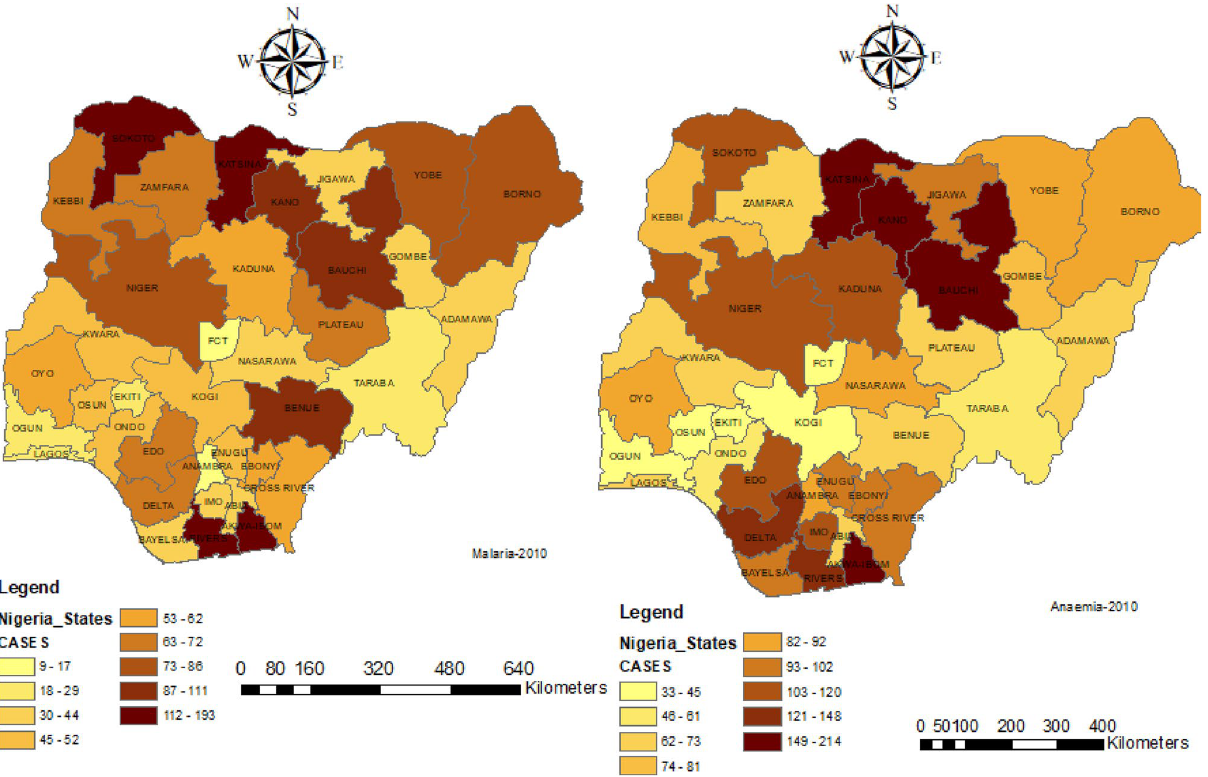
Figure 1. The 37 states including the capital territory of Nigeria showing the 2010 prevalence of malaria and anaemia of under-5 years of